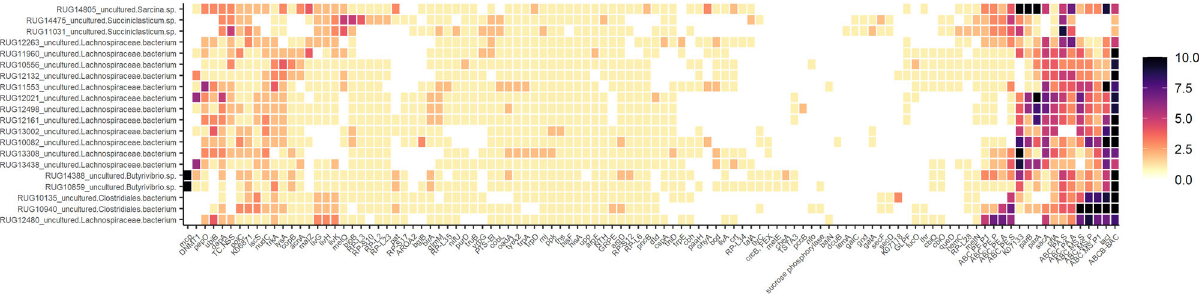
Fig. 6 Top 20 rumen uncultured genomes (RUGs) highly enriched with the 115 microbial genes host-genomically correlated to methane emissions with a probability of being higher or lower than 0 ( P 0 ) ≥ 0.95. Colour scale represents the number of unique proteins mapping into each KEGG orthologous group (i.e. microbial gene). Source data is in Supplementary Data 11. Full names of microbial genes are given in Supplementary